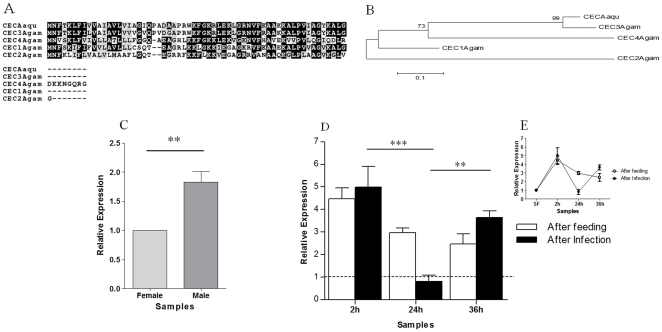
Characterization of cecropin induction in mosquitoes fed on sugar, blood, or infected blood.A: Multiple aminoacid sequence alignment of A. aquasalis and A. gambiae cecropin sequences. B: Phylogenetic tree constructed using neighbor-joining method. C–E: Expression levels of cecropin determined by RTPCR following various feeding regimens. C: Sugar-fed males and females, D and E: sugar-fed (dotted line and SF), blood-fed (AF) and P. vivax infected (AI) females. h–hours. Acession numbers of cecropin (cec) sequences from: A. aquasalis (Aaqu) (consensus of GR486610 and GR486612), and from A. gambiae (Agam) (Cec1 - AGAP000693-PA, Cec2 - AGAP000692-PA, Cec3–AGAP000694-PA and Cec4 - AGAP006722-PA). +−: s.e.m.; * p<0.05, ** 0.03>p>0.01, *** p<0.01.